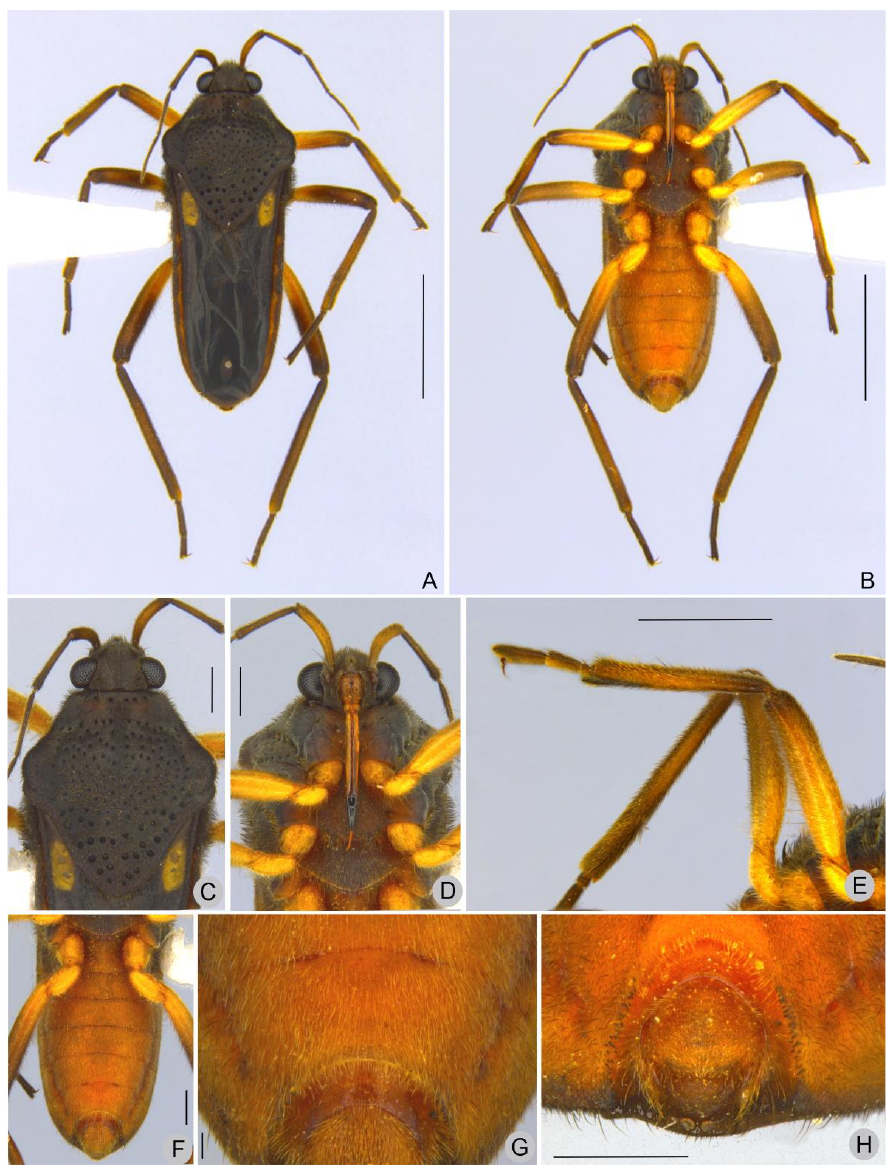
white to yellow, consisting of: a basal ovate macula not reaching the humeral angle and ending before the posterior margin of the pronotum, and an apical oval macula, smaller than the basal one; the absence of spines or teeth on the legs; the absence of rounded punc- tures on abdominal sterna; the absence of small black denticles on the body, except for those located on the apex of male abdominal segment VII and dorsolaterally on male abdominal segment VIII; and the male without lobes or projections on abdominal sternum VII.